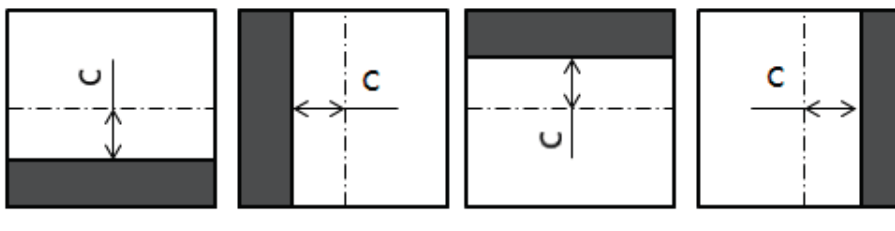
Figure 9. Comparison of the DOM evolutions for four different numbers of baffles.